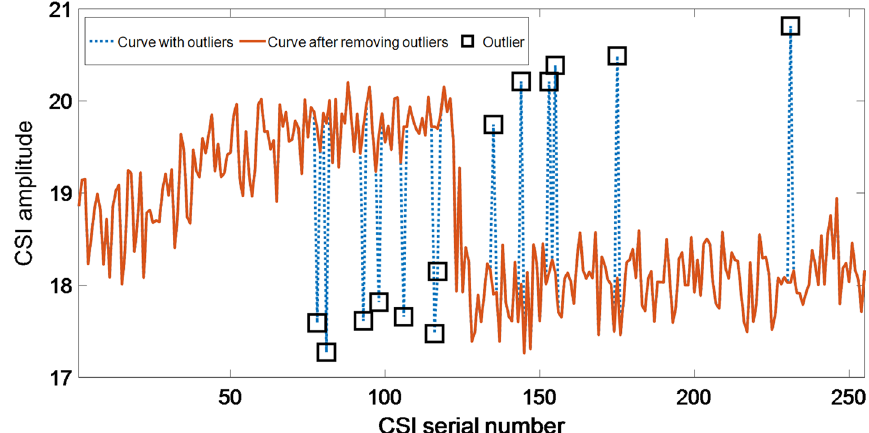
Fig. 2 Comparison before and after removing